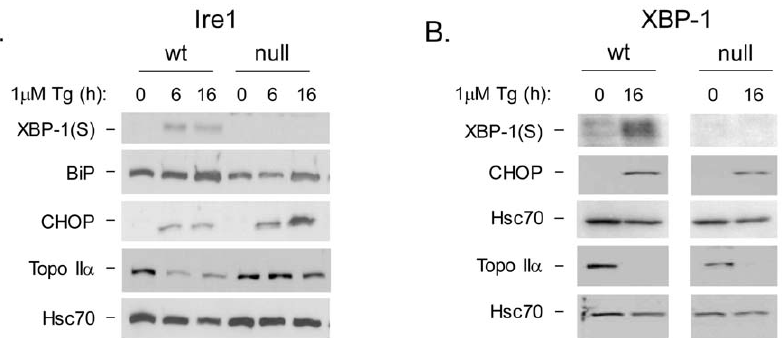
Figure 1. Ire1 regulates Topo II a protein levels in an XBP-1 independent manner. Ire1 ( A ) or XBP-1 ( B ) wild-type and knock-out cells were treated with thapsigargin for the indicated times. Cell lysates were prepared and analyzed by western blotting with the indicated antiserum. Hsc70 serves as a control for lysate loading. Two gels were used in panel B; a 10% gel to separate the smaller XBP-1(S) and CHOP proteins and an 8% gel for the larger Topo II a protein and thus there are two sets of loading controls.